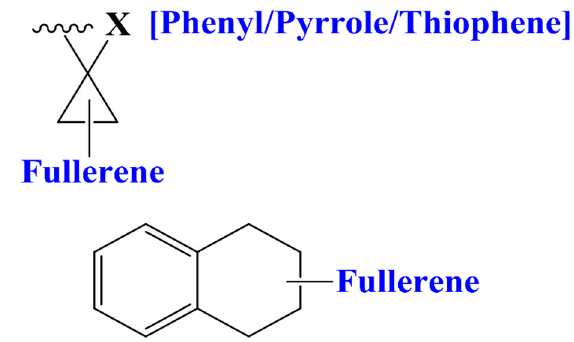
Figure 2. Important fullerene substituents for higher PCE.